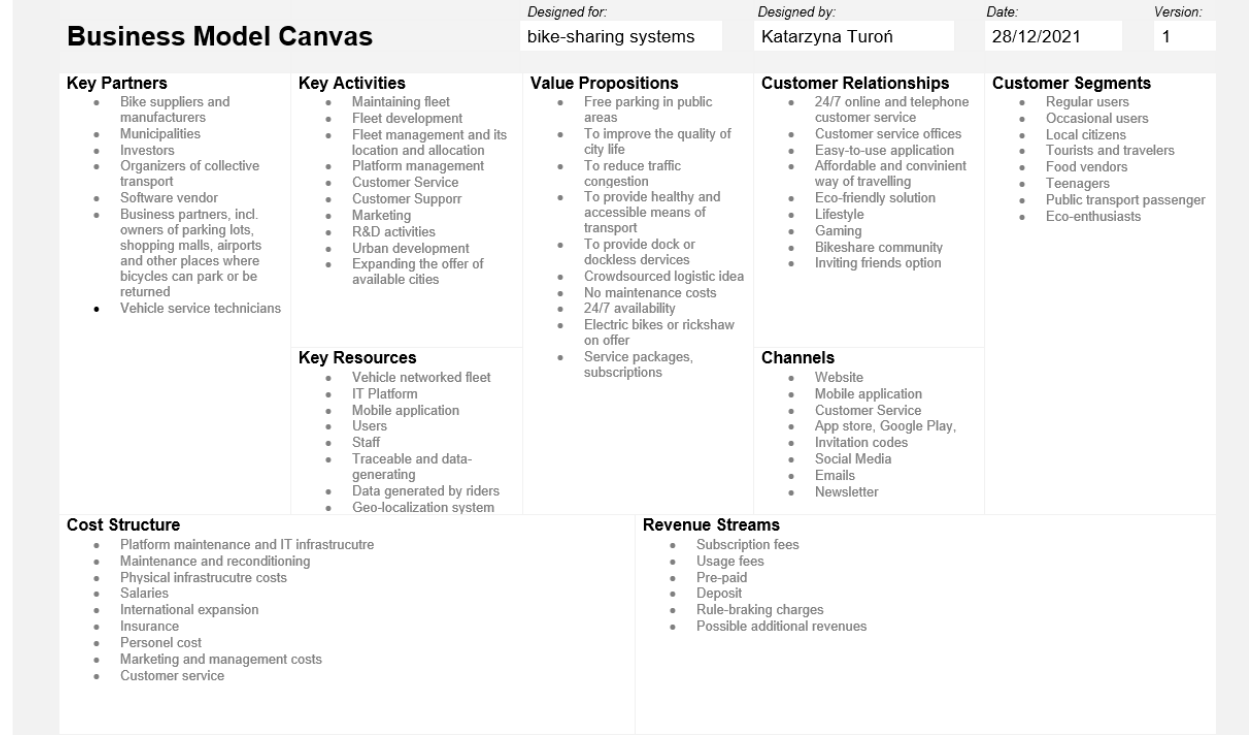
Figure 2. The bike-sharing business model based on the CANVAS concept. Source: author’s own elaboration.